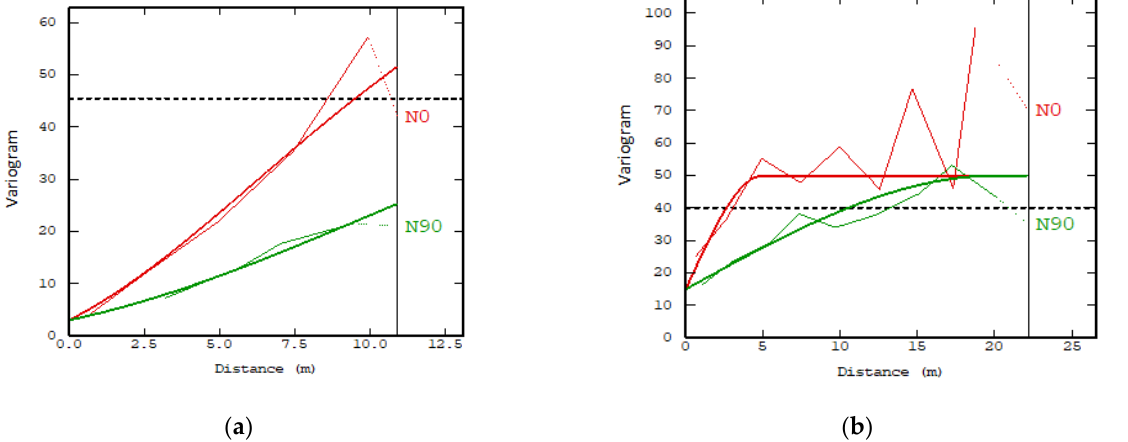
Figure 5. Experimental (thin line) and modeled (thick line) anisotropic variograms: ( a ) LGP-1 for ore-A with directions: north: 0° (red) and directions: north: 90° (green); ( b ) LGP-1 for ore-B with directions: north: 0° (red) and directions: north: 90° (green).